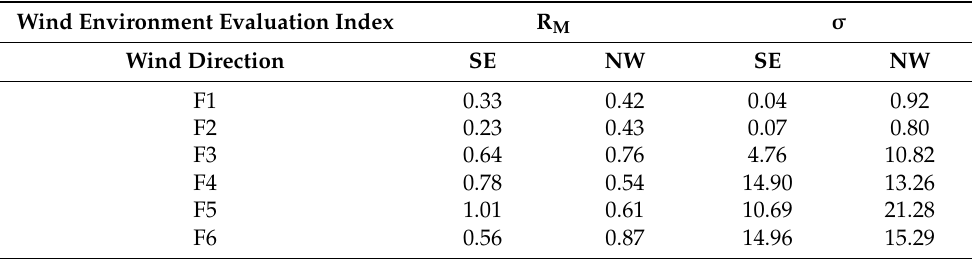
Table 8. Average wind speed ratio and wind speed dispersion at different wind directions for contour tortuosity.